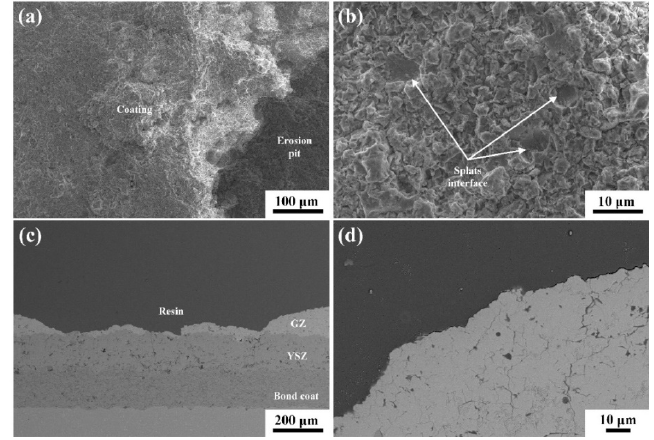
Figure 10. SEM micrographs of GZ TBC after the erosion test: ( a ) low magnification top view, ( b ) high magnification top view, ( c ) low magnification cross-section view, and ( d ) high magnification cross-section view.